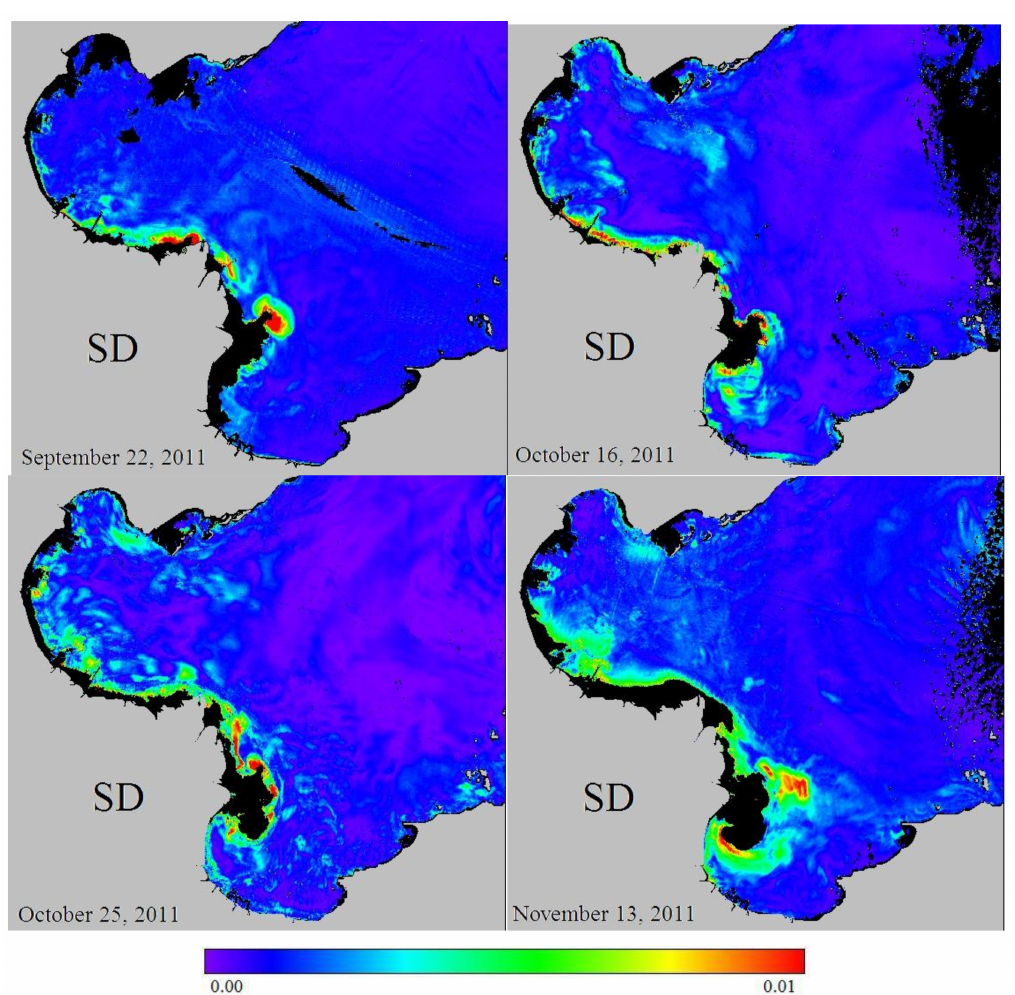
Figure 13. SD (standard deviation) maps of GOCI retrieved R rs (680) in the Yellow River Estuary and its adjacent areas on 22 September, 16 October, 25 October and 13 November 2011. Note that the major regions of R rs (680) diurnal variation were generally located in near-coastal waters and in the estuary of the Yellow